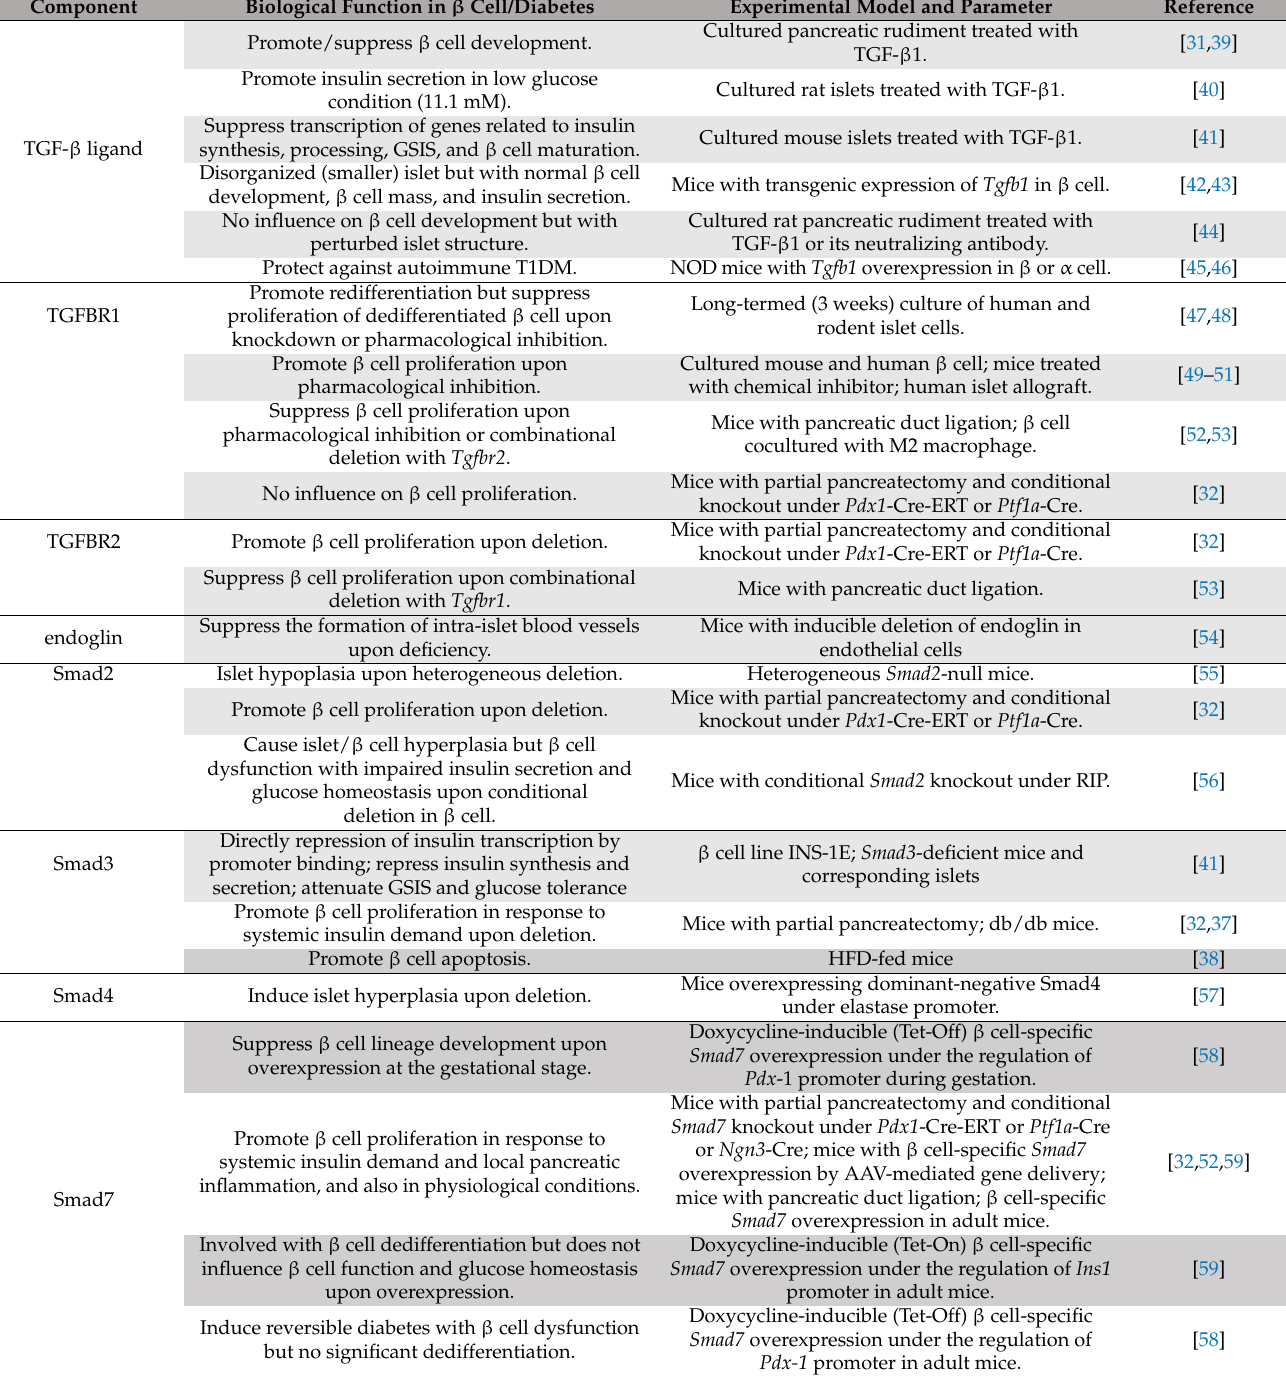
Table 1. Role of different components of TGF- β signaling in β cell